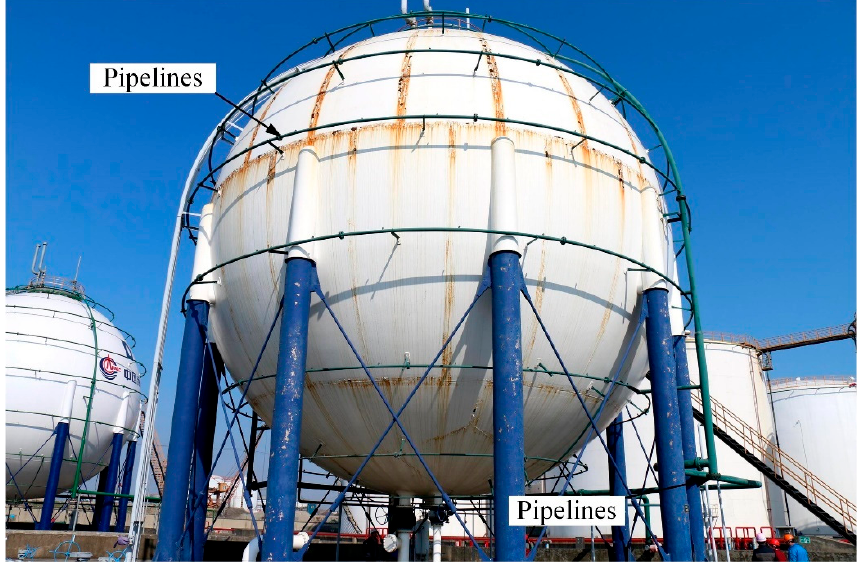
Figure 1. Circular pipelines outside spherical tanks.